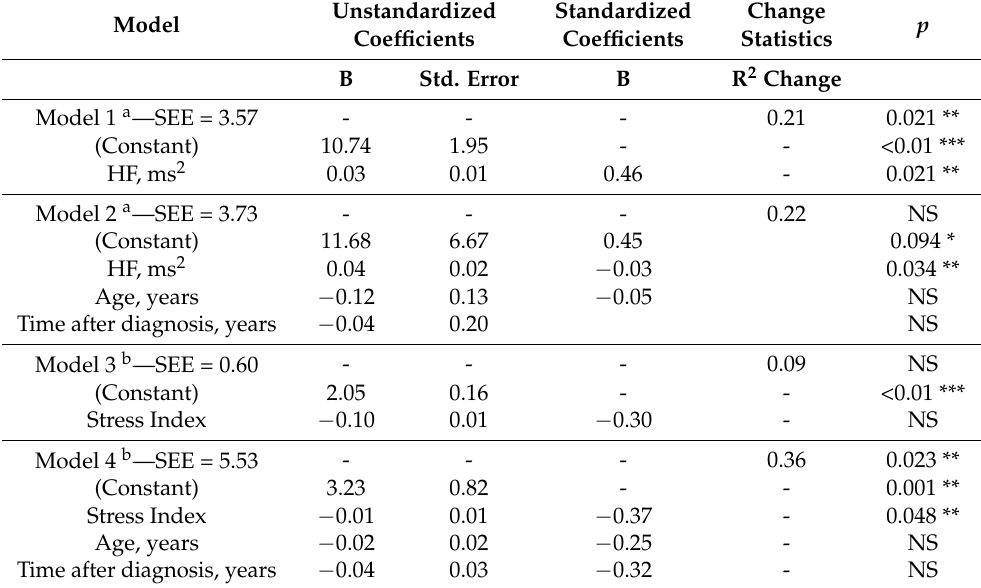
Table 5. Multiple linear regressions analysis between dependent and related independent